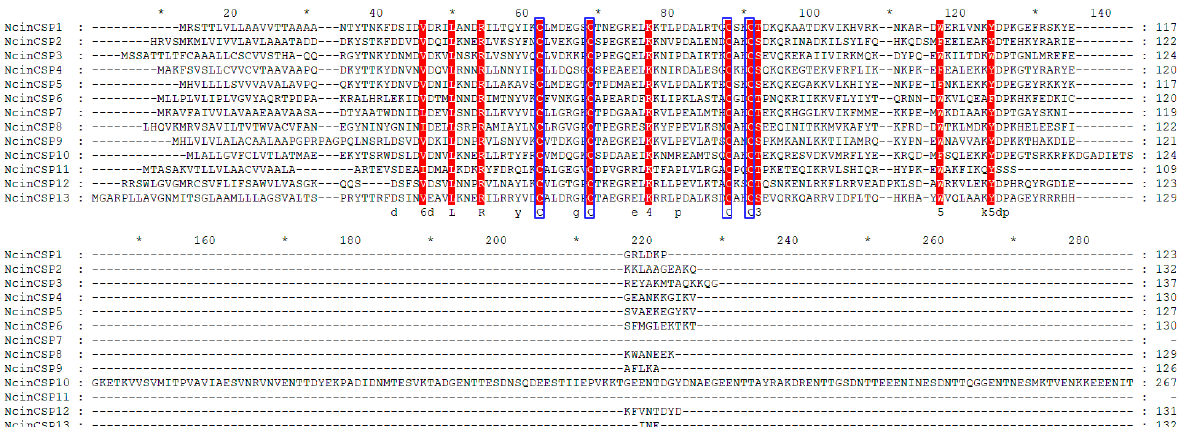
Figure 2. Sequence alignment of N. cincticeps CSPs. Sequences were aligned using the MEGA 6.0 and were presented using GeneDoc software. * indicates positions which have a single, fully conserved residue. Conserved amino acid residues are indicated by red letters. The four conserved Cys was indicated at the bottom of the alignment with a blue frame.